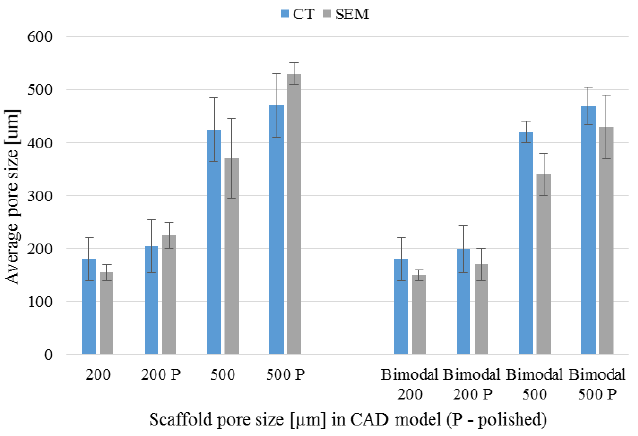
Figure 9. Scaffolds’ pore size before and after chemical polishing (P) measured by µ-CT/SEM methods.